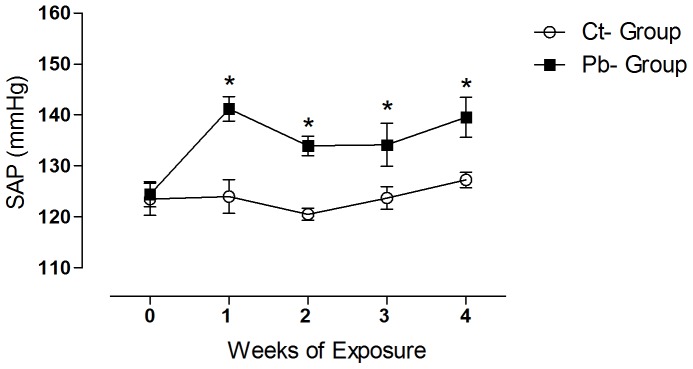
Systolic Arterial Pressure, obtained by tail plethysmography before (0) and during a 4 week period of Pb exposure.Symbols represent mean ± SEM (N = 7 for each group). Open circles- controls, filled squares- lead treated group. *p<0.05, Ct-group vs. Pb-group, two-way ANOVA, followed by Bonferroni’s test.